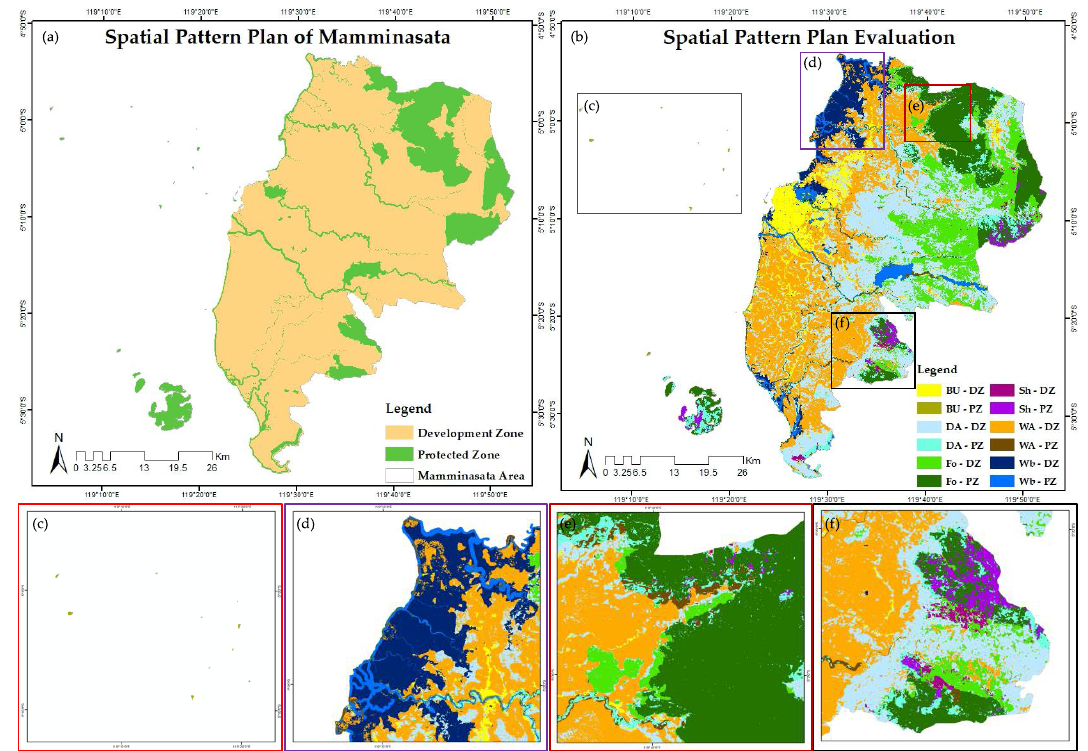
Figure 11. Spatial pattern plan from the Government ( a ); spatial pattern plan evaluation ( b ); Spermonde islands ( c ); waterbody area ( d ); forest area ( e ); and shrub area ( f ). Note: BU—built-up area; DA—dryland agriculture; Fo—forest; Sh—shrub; Wb—waterbody; WA—wetland agriculture; DZ—development zone; and PZ—protected zone.